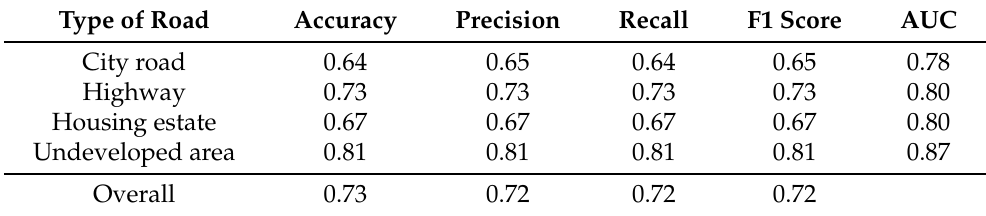
Table A2. Evaluation metrics of the kNN classifier on the test dataset.